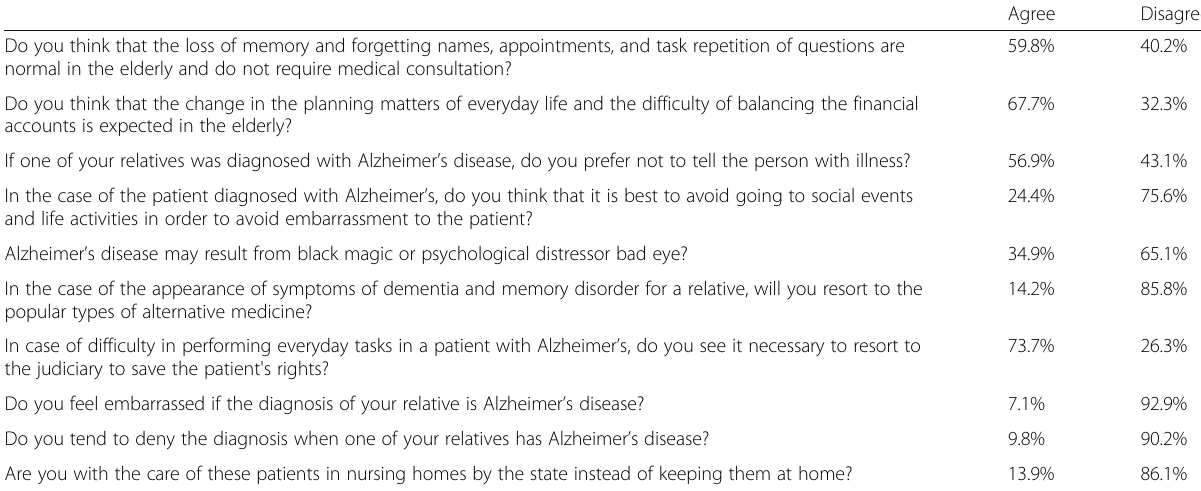
Table 2 Awareness of Alzheimer ’ s